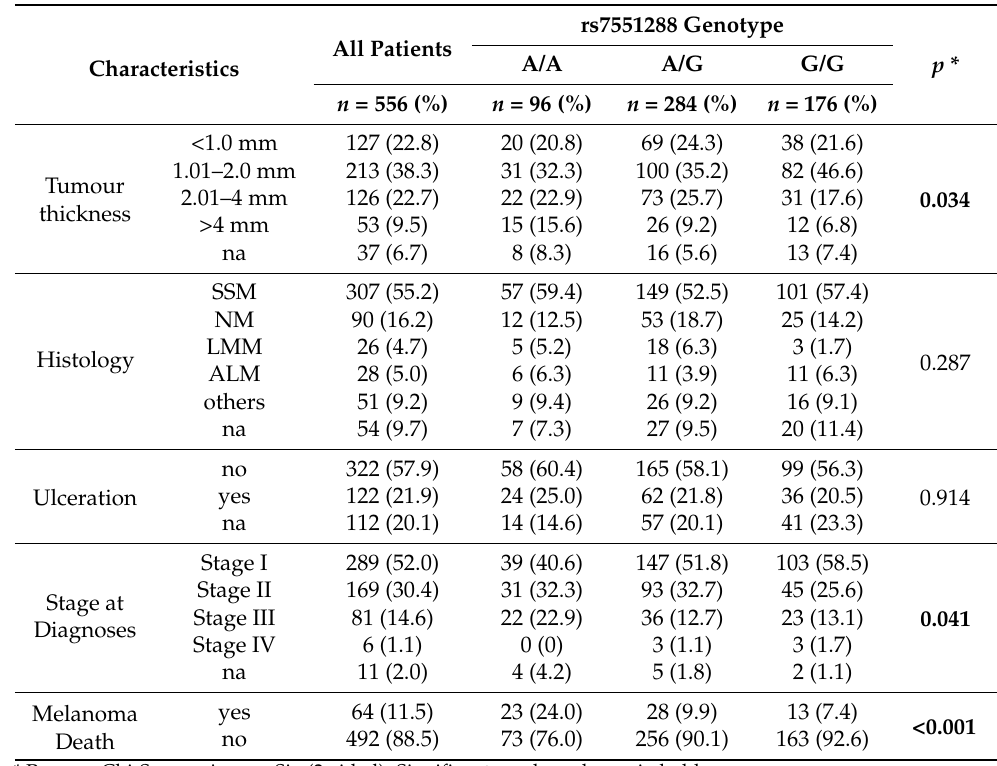
Table 2. Tumour characteristics and rs7551288